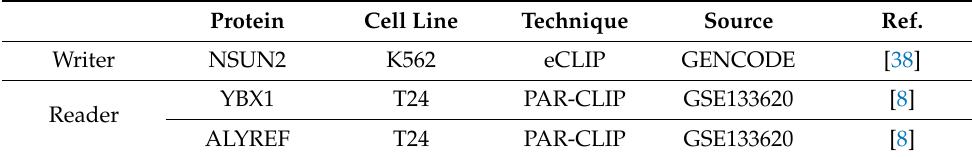
Table 2. Target sites of m5C regulators identified by Par-CLIP or eCLIP.